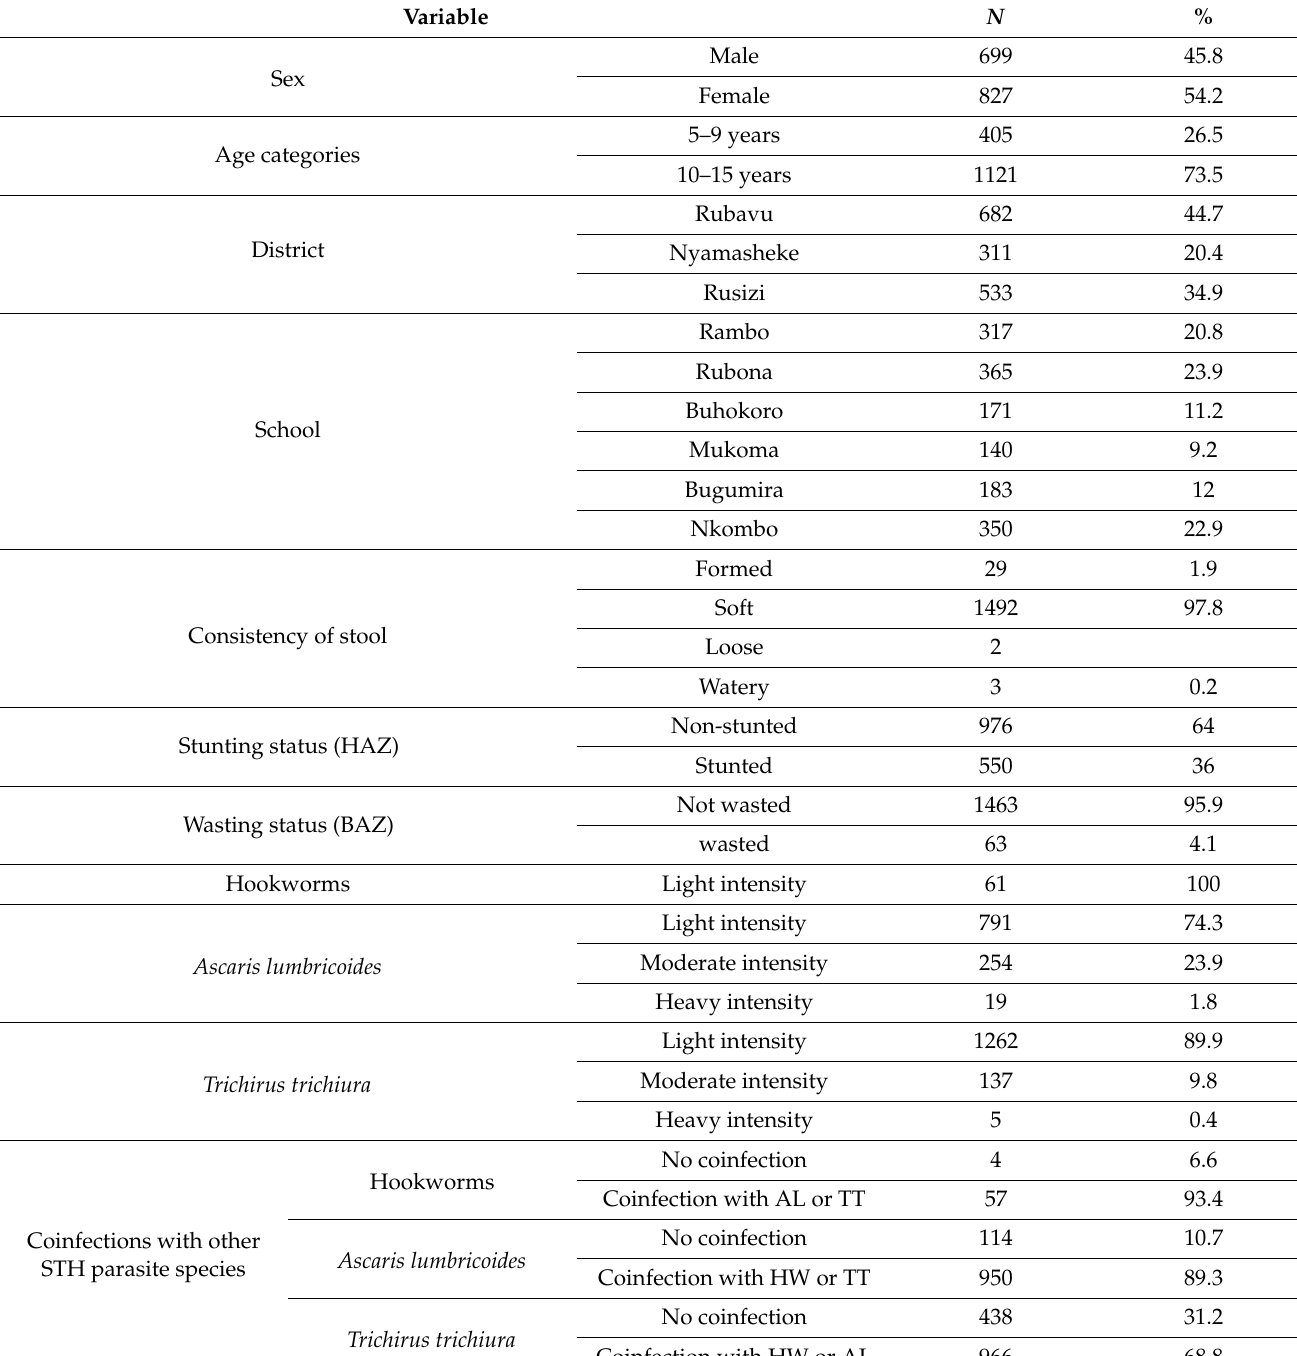
Table 1. Socio-demographic and baseline characteristics of study